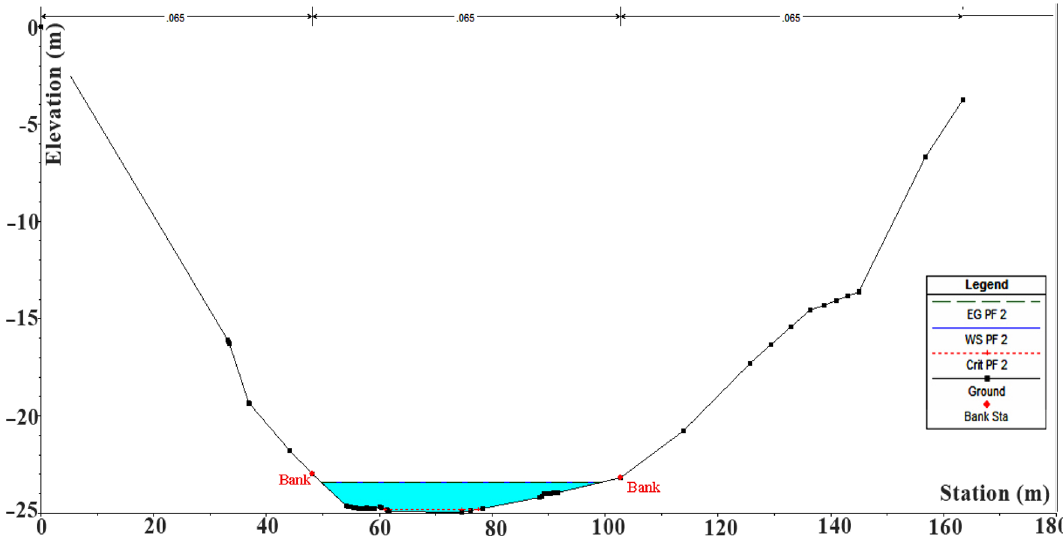
Fig. 4 A cross section of the Qarasu river and water depth (discharge = 1.5 m 3 /s, Ground is river bed topography and WS PF2 is water depth)